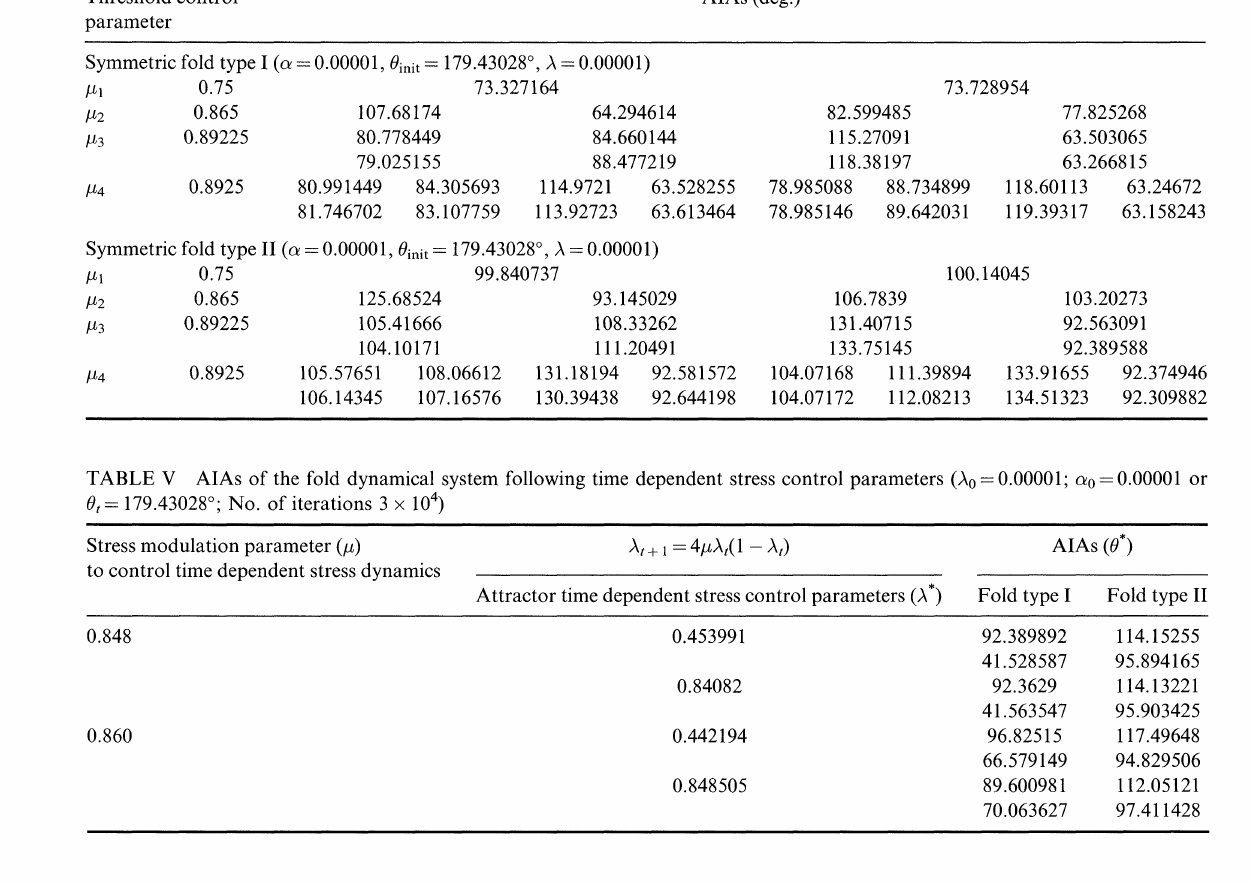
TABLE IV AIAs at the threshold regulatory forces after 3 104 time steps: The dynamical rule is simple first order nonlinear difference equation with time dependent stress control parameter Threshold control AIAs (deg.)